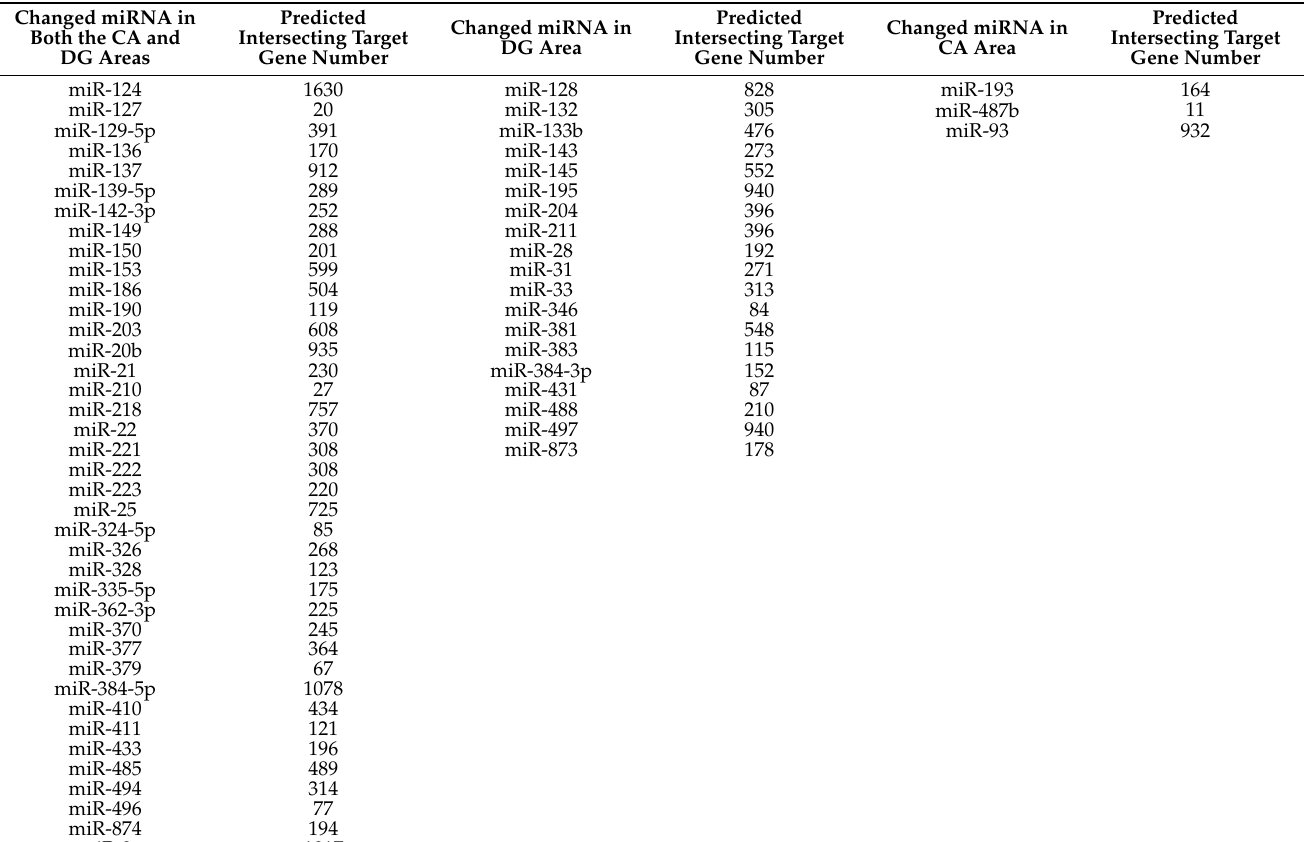
Table 3. Numbers of predicted intersecting target genes of changed miRNAs.